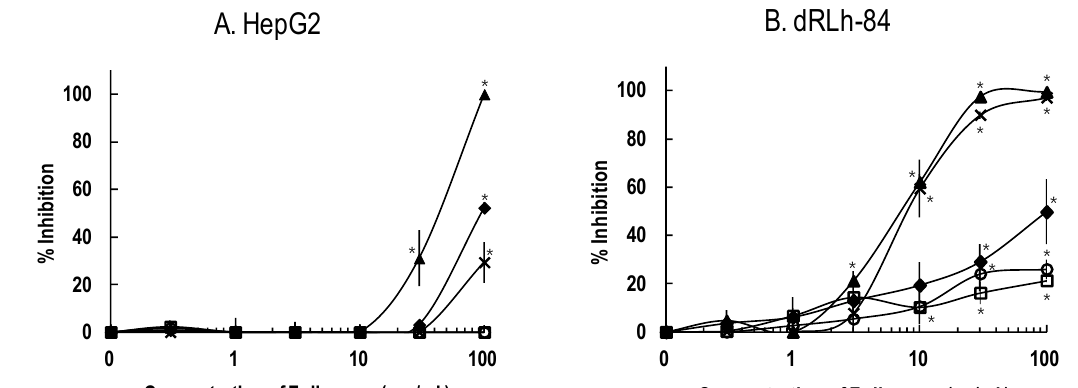
Figure 5. Mitochondrial activity of fullerene and hydroxylated fullerenes in liver cells after exposure for 3 days. Three types of cells, HepG2 ( A ); dRLh-84 ( B ); and primary cultured rat hepatocytes ( C ) were treated with fullerene and hydroxylated fullerenes with the same concentrations as employed in the cell viability assay (the sample symbols are the same as in Figure 3). After exposure for 3 days, the inhibition rate (%) of mitochondrial activity was evaluated. Each data represents the mean ± SD ( n = 3). * Significantly different from the control: p <